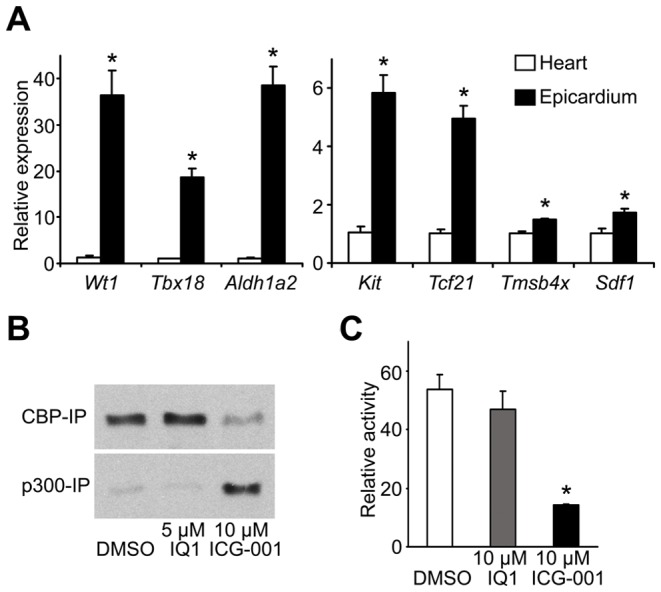
ICG-001 modulates Wnt signaling in rat epicardial mesothelial cells (EMCs).(A) Quantitative PCR analysis (qPCR) of mouse hearts and epicardium demonstrates that the epicardium expressed significantly higher levels of Wt1, Tbx18, Aldh1a2, Kit, Tcf21, Tmsb4x and Sdf1 than the remainder of the heart. *P<0.05. (B) β-catenin co-immunoprecipitation (co-IP) analysis shows that ICG-001 induced β-catenin coactivator switching from CBP to p300 in rat epicardial cells (EMCs). ICG-001 decreased β-catenin interaction with CBP (top panel) and increased the interaction with p300 (bottom panel) in rat EMCs. IQ1 slightly increased β-catenin interaction with CBP (top panel) and did not change the interaction with p300 (bottom panel). (C) Rat EMCs were transiently transfected with the TOPFlash reporter plasmid and assessed for luciferase activity. ICG-001 significantly decreased TOPFlash activity in rat EMCs. *P<0.05. Data are presented as mean ± s.e.m.